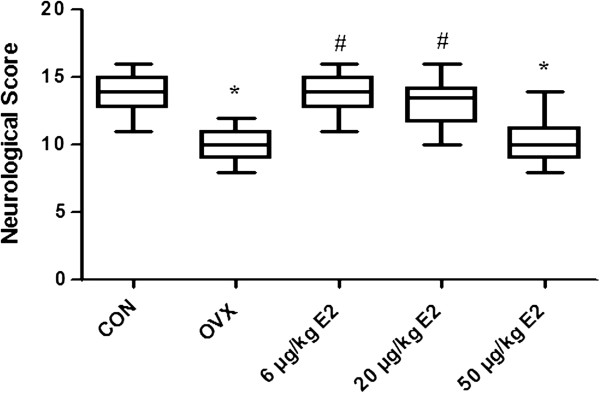
Neurological behavior score. The Garcia Test was applied to determine the neurological deficit in the rats receiving ischemia–reperfusion injury by MCAO in animals receiving different doses of E2. The OVX group demonstrated significantly lower neurological deficit scores than the control group. Treatment with 6 μg/kg or 20 μg/kg E2 significantly improved the neurological deficit scores. Treatment with 50 μg/kg E2 resulted in significantly lower neurological deficit scores (*p < 0.01 v.s. the control group, # p < 0.05 v.s. the OVX group).